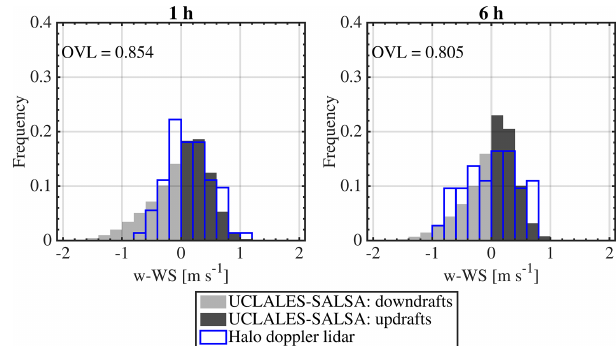
Figure 10. Comparison of model-based distributions of vertical wind at cloud base during case 2, 31 October 2020, to those re- trieved from Doppler lidar observations. Each panel shows the over- lapping index value (OVL) as an indicator of agreement between distributions.